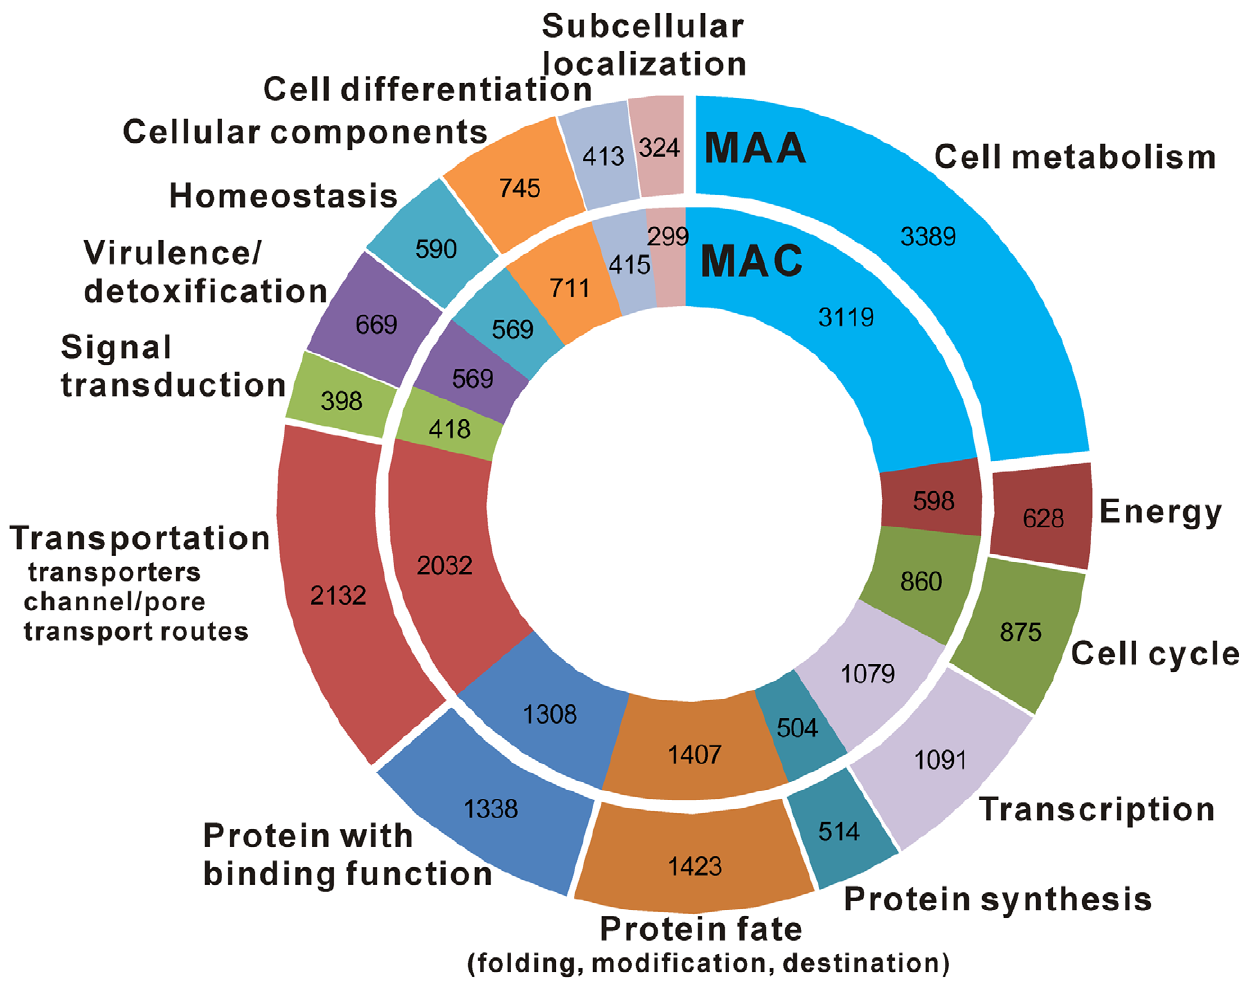
Figure 4. Functional classification and comparison of M.anisopliae and M.acridum proteins. Each circle represents the relative fraction of genes represented in each of the categories for each genome. The gene numbers are also shown.